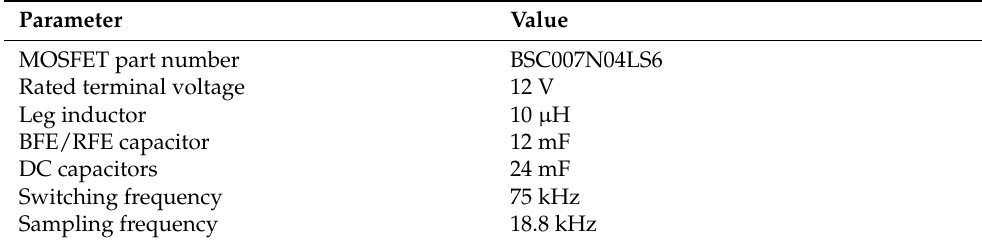
Table 3. BFE and RFE converter